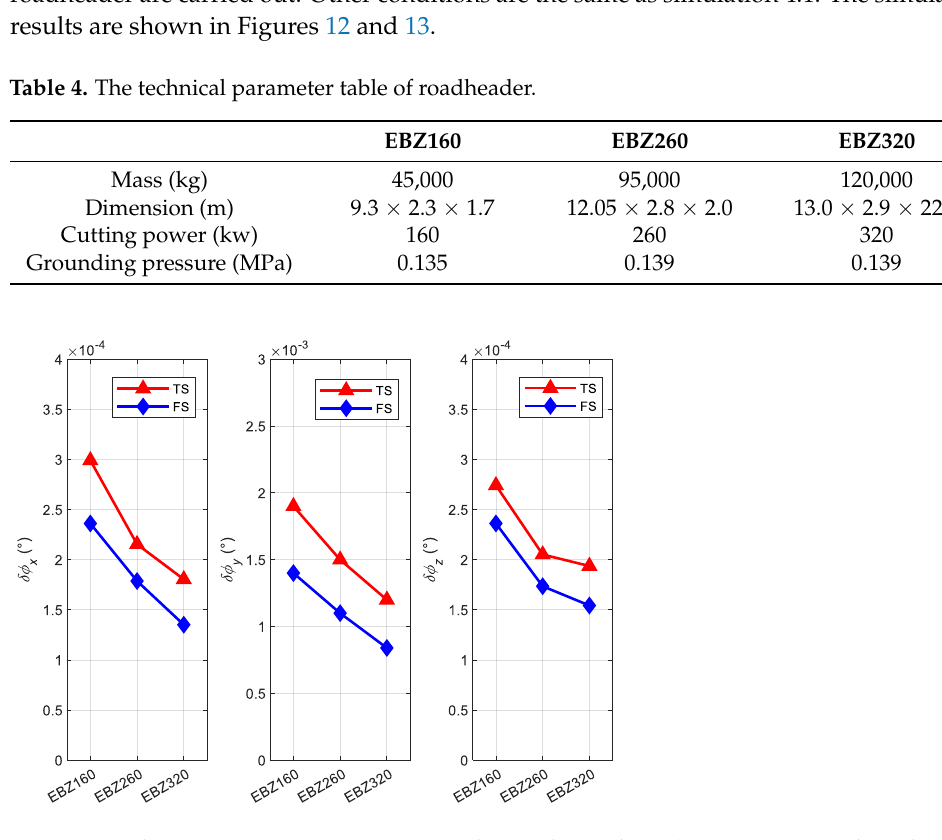
Figure 12. The coning error statistics using three-subsample (TS) compensation algorithm and four-subsample (FS) compensation algorithm under different types of roadheaders.